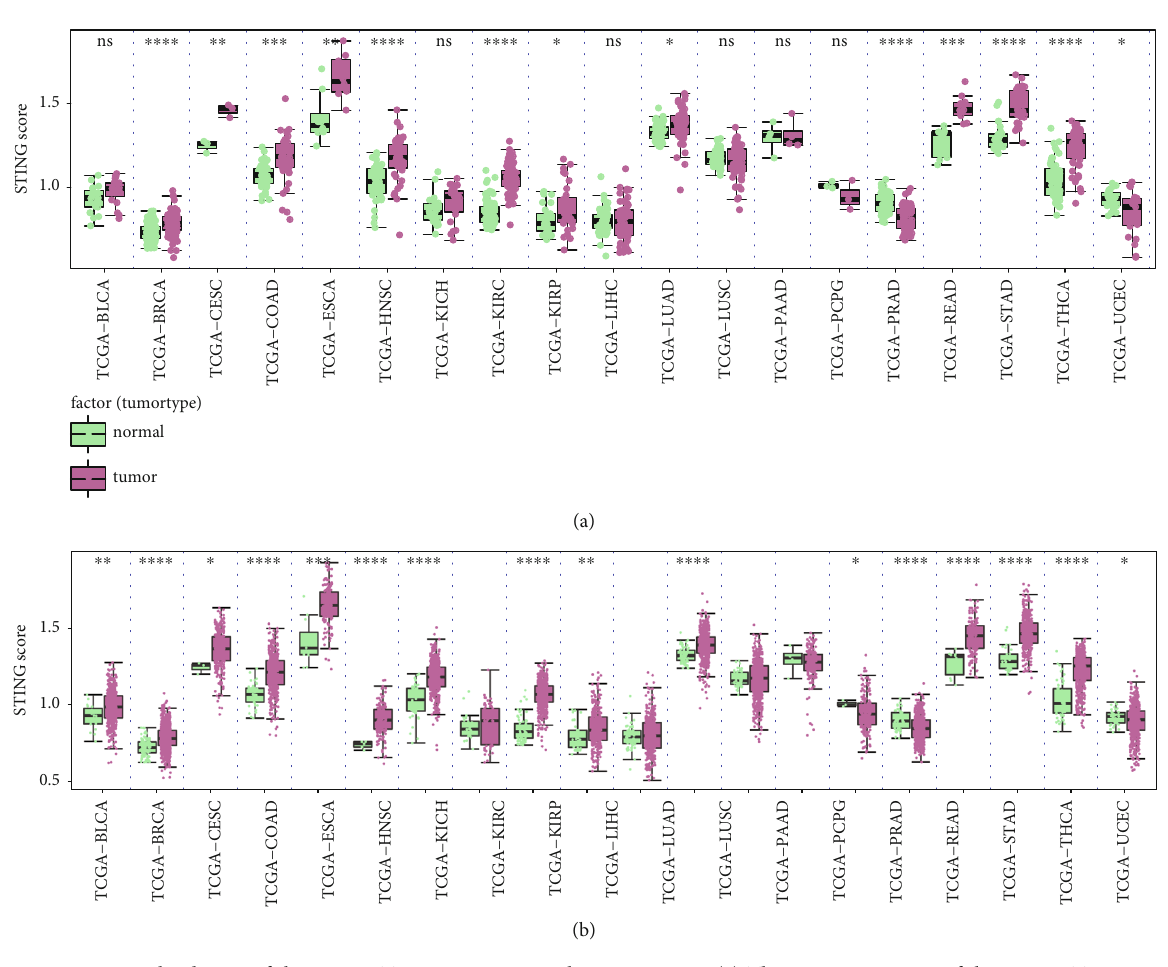
Figure 2: Expression landscape of the cGAS-STING sensor across human cancers. (a) The expression score of the cGAS-STING signal in paired tumor and nontumor tissues. (b) Signi fi cant di ff erence of the cGAS-STING score between tumor and normal samples. BLCA: bladder urothelial carcinoma; BRCA: breast invasive carcinoma; CESC: cervical squamous cell carcinoma and endocervical adenocarcinoma; COAD: colon adenocarcinoma; ESCA: esophageal carcinoma; HNSC: head and neck squamous cell carcinoma; KICH: kidney chromophobe; KIRC: kidney renal clear cell carcinoma; KIRP: kidney renal papillary cell carcinoma; LIHC: liver hepatocellular carcinoma; LUAD: lung adenocarcinoma; LUSC: lung squamous cell carcinoma; PAAD: pancreatic adenocarcinoma; PCPG: pheochromocytoma and paraganglioma; PRAD: prostate adenocarcinoma; READ: rectum adenocarcinoma; STAD: stomach adenocarcinoma; THCA: thyroid carcinoma; UCEC: uterine corpus endometrial carcinoma. ∗ P < 0 : 05 ; ∗∗ P < 0 : 01 ; ∗∗∗ P < 0 : 001 ; ∗∗∗∗ P < 0 : 0001